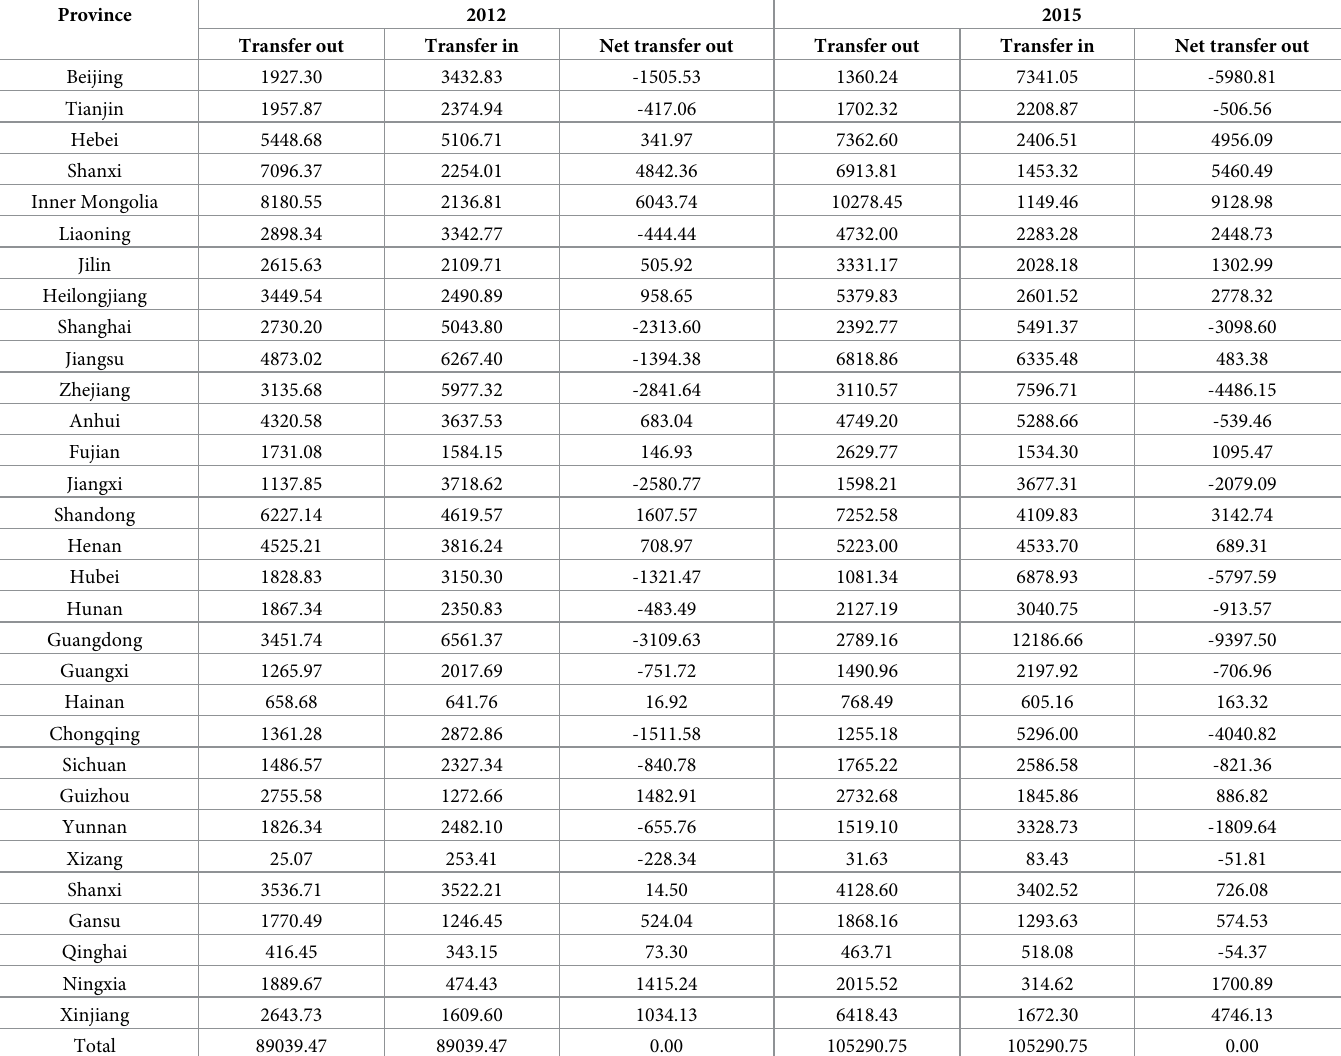
Table 3. Embodied carbon trade by province in China in 2012 and 2015 (unit: 10,000